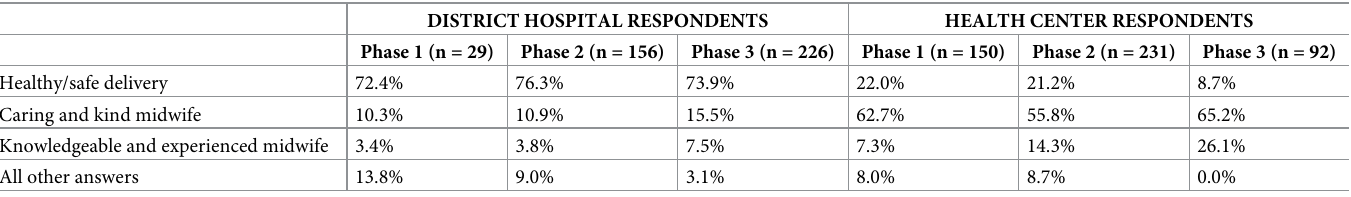
Table 5. Reasons given for perceived care among participants who rated perceived quality of care at triage as excellent or very